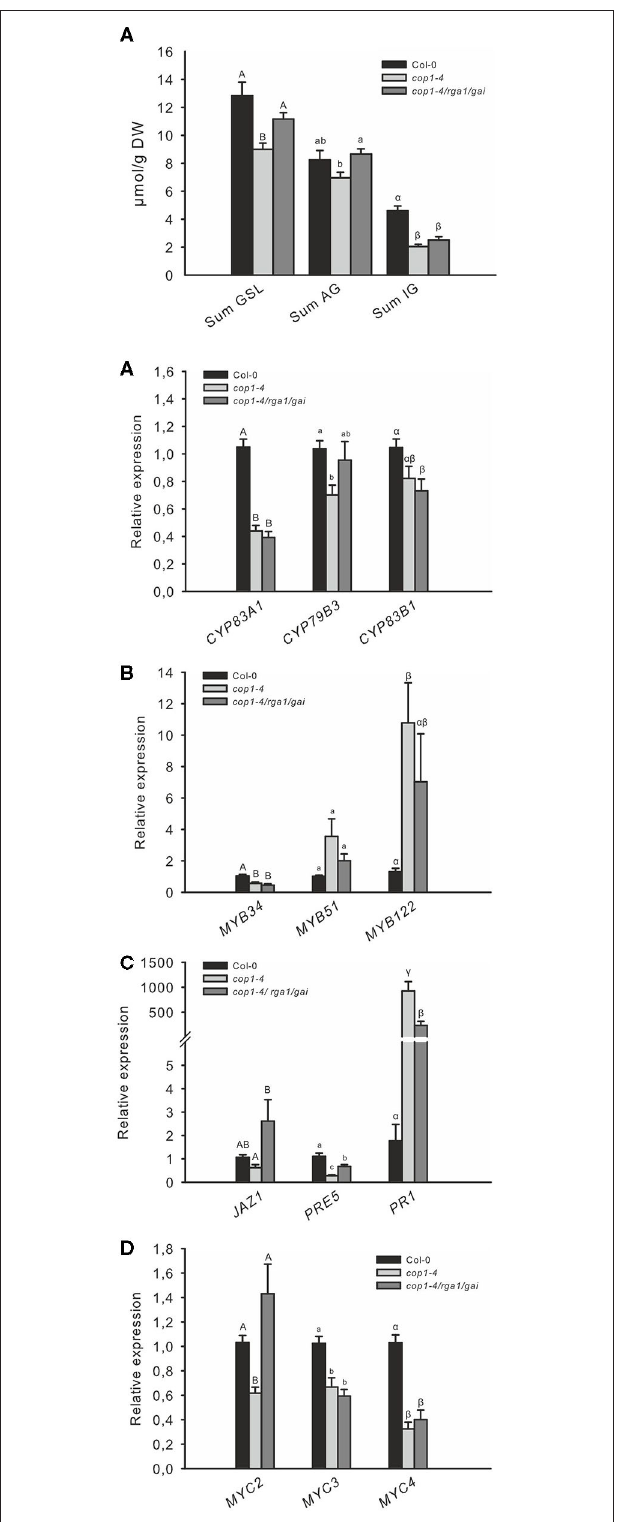
FIGURE 4 | The low GSL level of cop1 mutant is partially complemented by the absence of DELLAs. The absence of the two DELLA proteins, RGA1 and